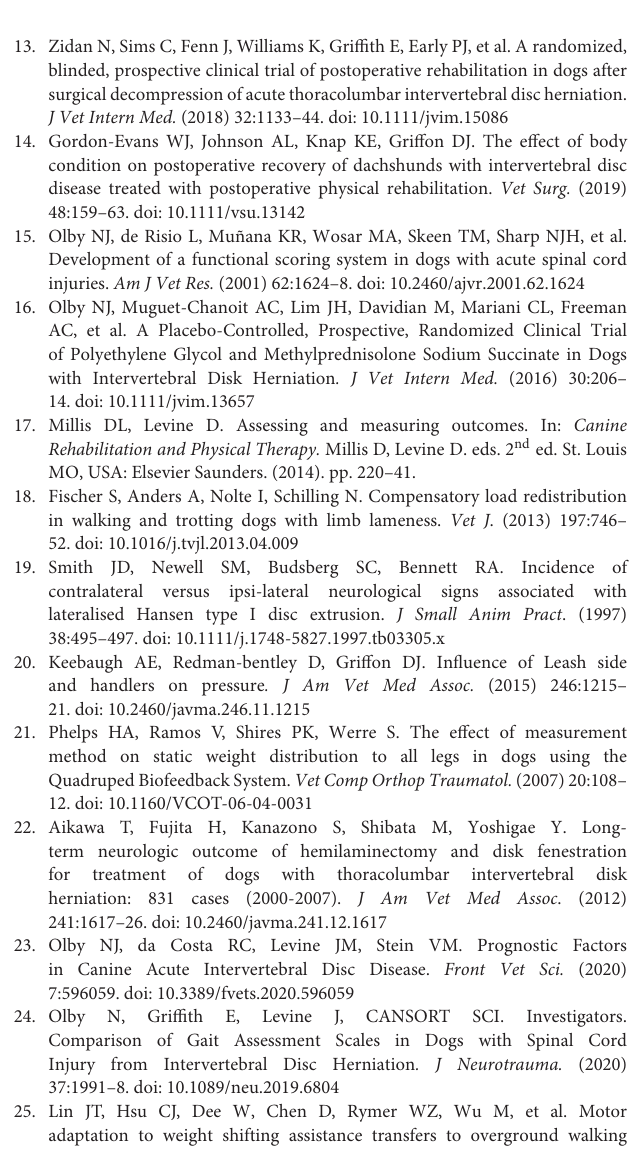
Supplementary Figure 1 | Two bathroom scales stance, side view (left) and top view (right). Supplementary Figure 2 | Four kitchen scales stance, side view (left) and top view (right). Supplementary Figure 3 | Body and limb circumference measurements. Top row: cranial trunk girth, cranial trunk girth close-up, thigh girth; Bottom row: caudal trunk girth, caudal trunk girth